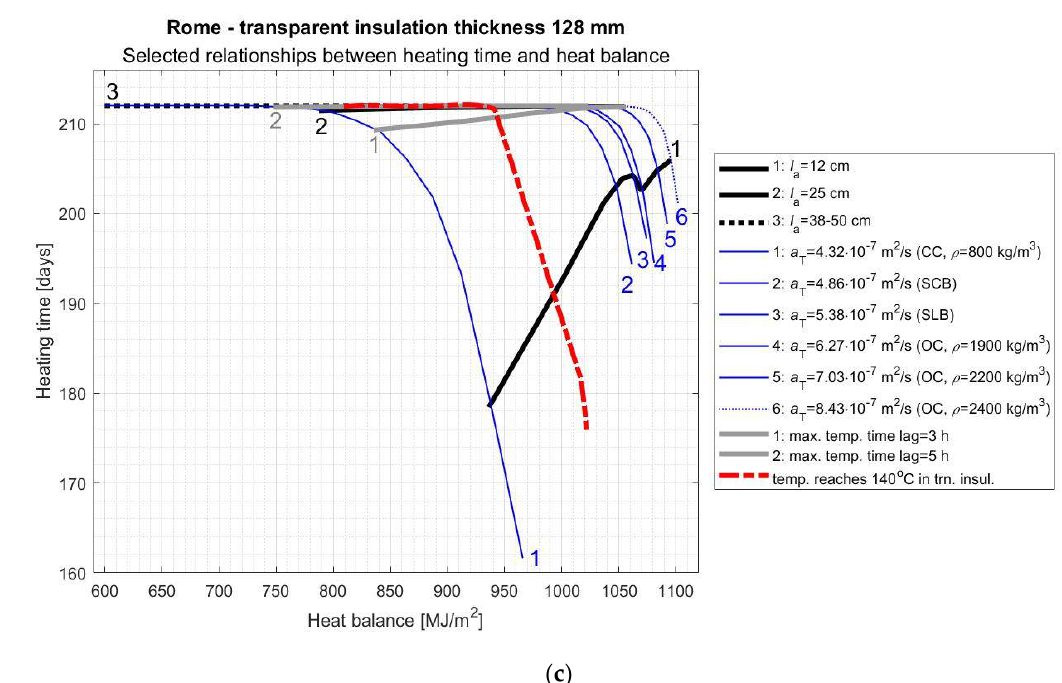
Figure 11. Relationship between the heating time and heat balance for the AL depending on its selected most important features. TI thickness: ( a ) 48 mm, ( b ) 88 mm, ( c ) 128 mm. Location: Rome.